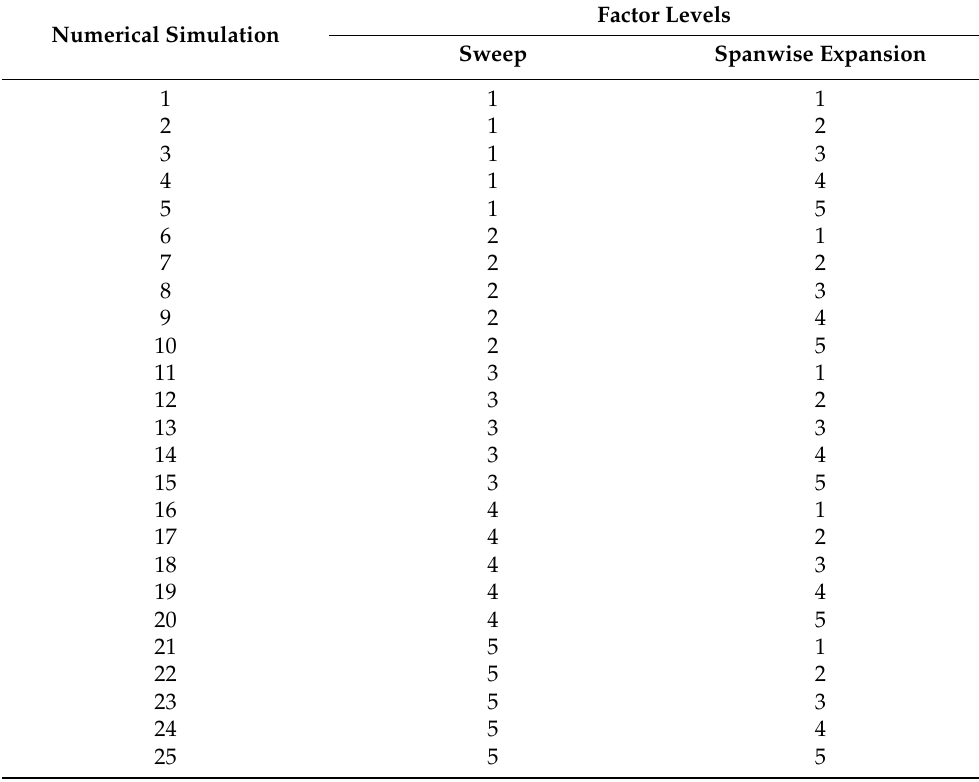
Table 4. Taguchi orthogonal array for